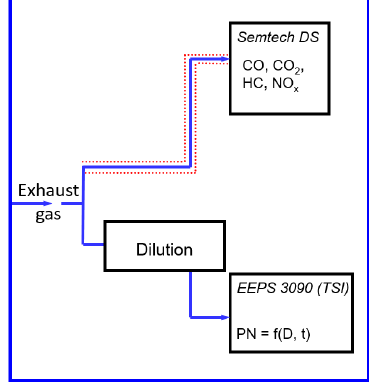
Figure 6. Exhaust gas